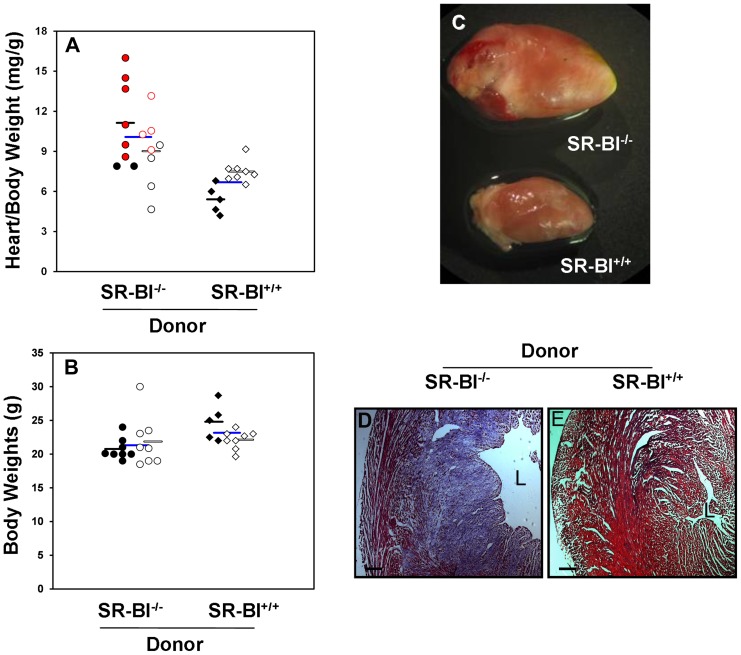
Restoration of SR-BI expression in BM derived cells attenuates diet induced increases in heart size and cardiac fibrosis in SR-BI-null/apoE-hypomorphic mice.
A. Ratios of heart weight to body weight (HW:BW) are plotted for SR-BI−/− → SR-BI−/− mice (circles) and SR-BI+/+ → SR-BI−/− mice (diamonds) fed the HFCC diet for 4 weeks. Red symbols identify those SR-BI−/− → SR-BI−/− mice which appeared to be in poor health or were moribund at collection. Closed symbols denote males and open symbols denote females. Horizontal bars indicate the mean heart/body weight ratios (black bars  =  males, open bars  =  females, blue bars  =  pooled males and females). Data passed the Shapiro-Wilk test for normality and was analyzed by the Student’s T test; P<0.0006 for SR-BI−/− → SR-BI−/− vs SR-BI+/+ → SR-BI−/− mice. B. Body weights from the same mice as in A are plotted for male (closed symbols) and female (open symbols) SR-BI−/− → SR-BI−/− (circles) and SR-BI+/+ → SR-BI−/− (diamonds). Bars denote average body weights: black bars  =  males, open bars  =  females; blue bars  =  pooled male + female mice. Differences in body weights between males (P = 0.006) and when males and females were pooled (P = 0.03) were significant, but females were not, by Student’s T test. C. Appearance of hearts from SR-BI−/− → SR-BI−/− and SR-BI+/+ → SR-BI−/− mice after 4 weeks of HFCC diet feeding. D–E. Trichrome staining of cross sections of hearts from SR-BI−/− → SR-BI−/− (D) and SR-BI+/+ → SR-BI−/− mice (E) after 4 weeks of HFCC diet feeding. Healthy myocardium appears red while collagen-rich fibrotic areas appear blue. L indicates the lumen of the left ventricle. Representative images are shown in C–E. Scale bars  =  300 µm.